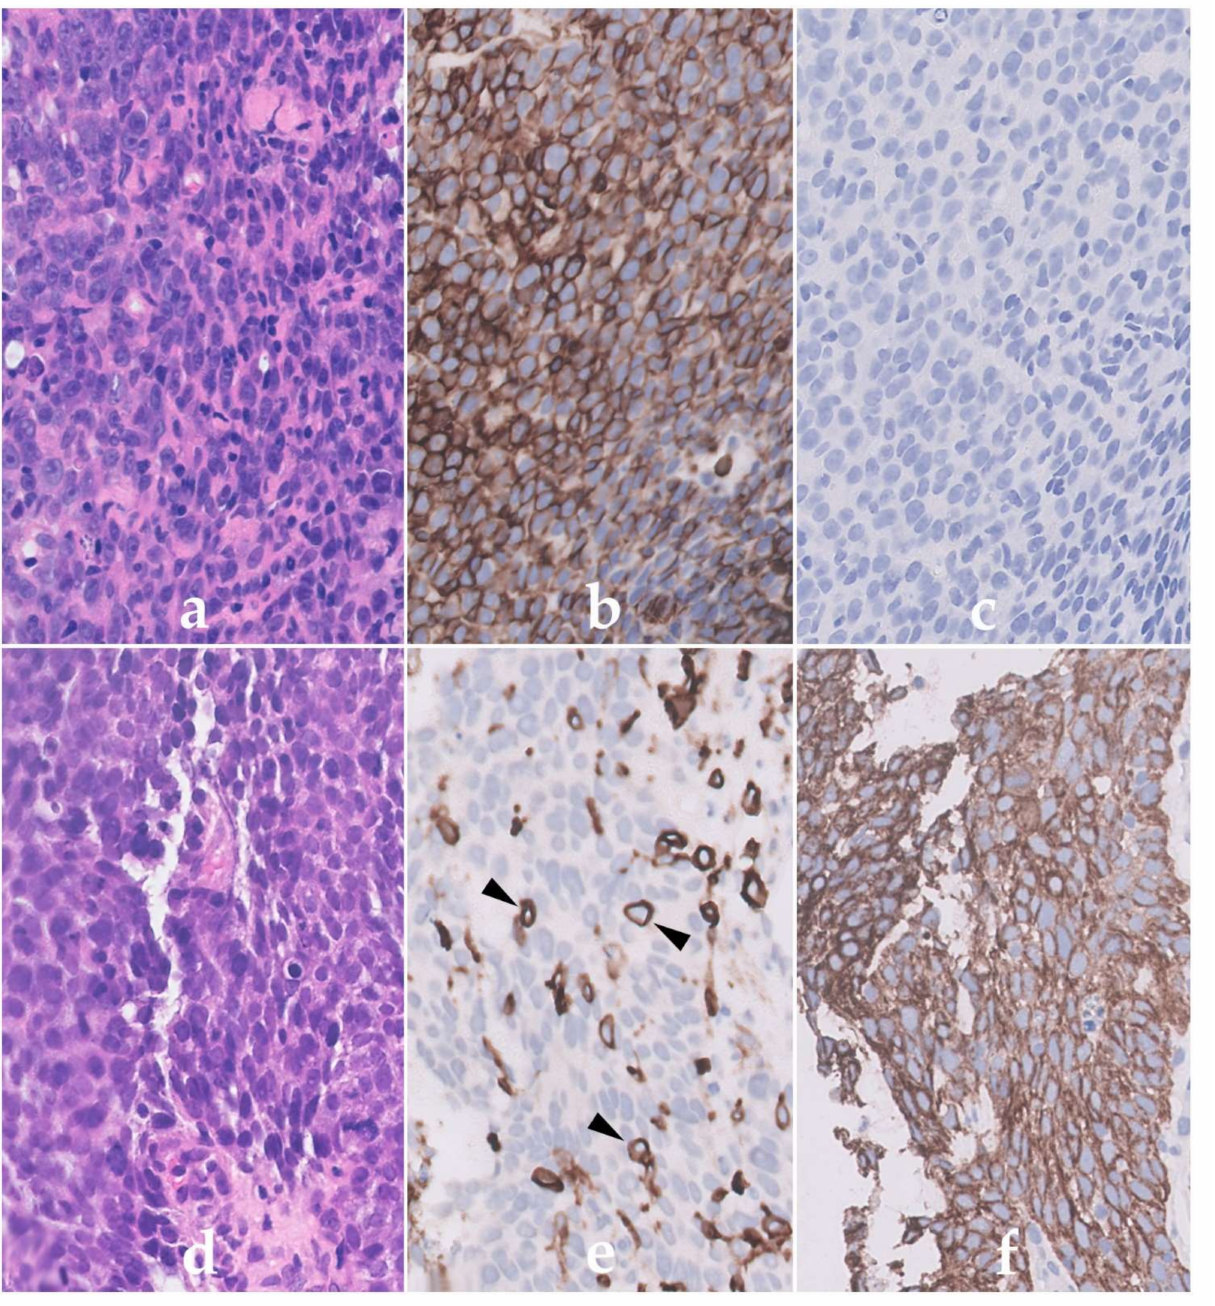
Figure 1. Immunoperoxidase labelling of formalin sections of a Non-Hodgkin’s lymphoma lym- phoma (NHL) ( a – c ) and a carcinoma ( d – f ) using the anti-CD45 antibody PD7/26. Haematoxylin and eosin labelling shows the presence of cells with a similar morphology in ( a ) the NHL and ( d ) carcinoma. The NHL cells in ( b ) are however strongly positive for CD45 (brown) but lack cytoker- atin ( c ) confirming their haematopoietic origin. In contrast, the epithelial cells of the carcinoma are ( e ) CD45 negative but ( f ) express cytokeratin. Note the labelling of the scattered normal CD45-positive lymphoid cells (arrowed) within the carcinoma in ( e